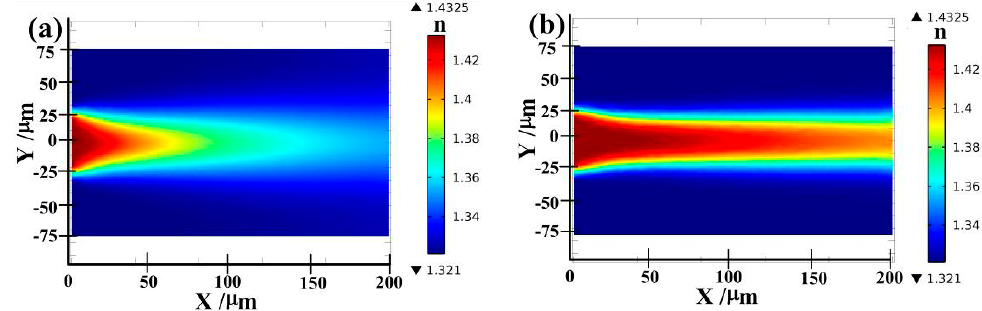
Figure 3. The refractive index profiles in the xoy plane with different diffusion coefficient D (with a fixed mass fraction of 0.3, and Q clad = 8, Q core = 8 × 10 3 pL/s). ( a ) D = 1 × 10 − 9 m 2 /s; ( b ) D = 4×10 − 10 m 2 /s.